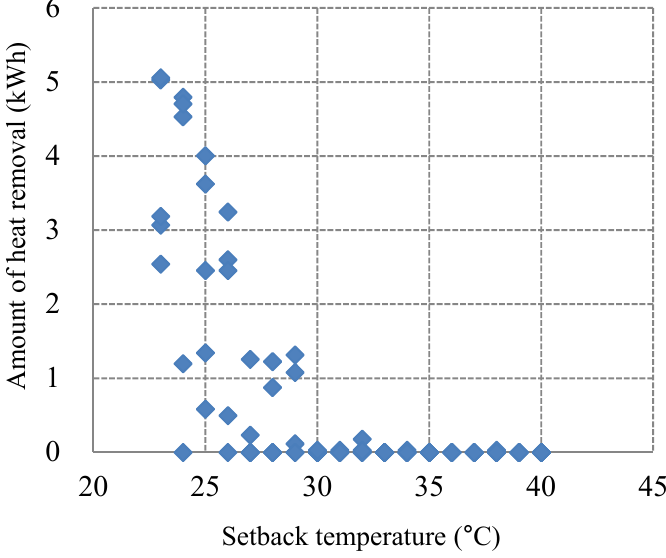
Figure 9. Relationship between the setback temperature and the amount of heat